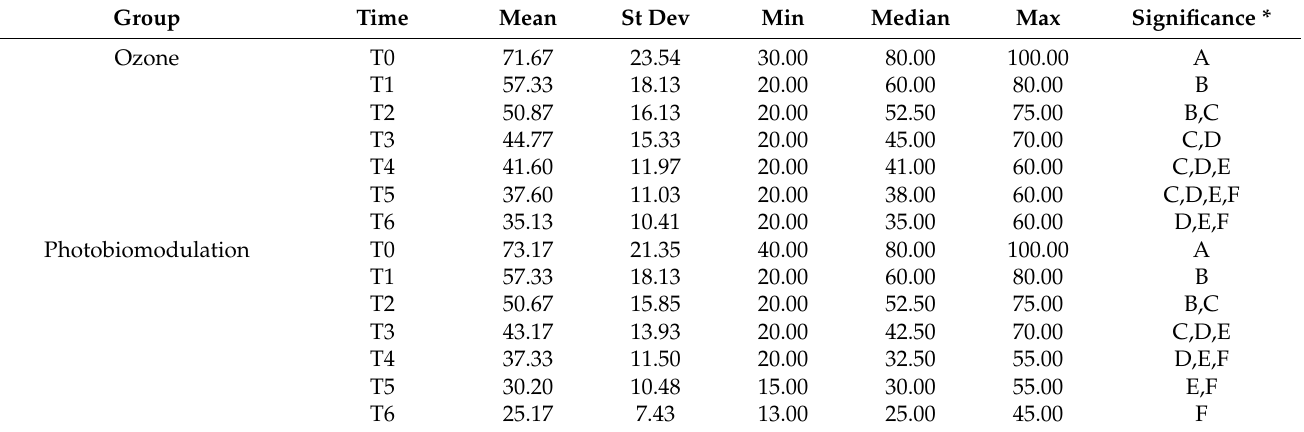
Table 5. Descriptive and inferential statistics of Bleeding on Probing measurements